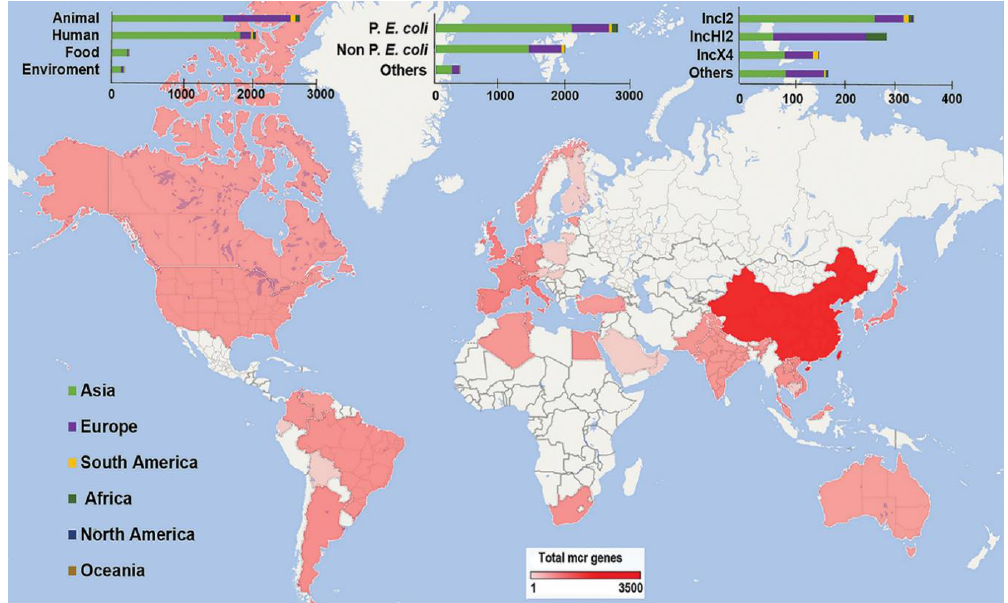
Figure 2. Global view of mcr genes along with the various hosts, bacteria and plasmid types. White colored countries refer to countries that have not yet reported studies on mcr genes.